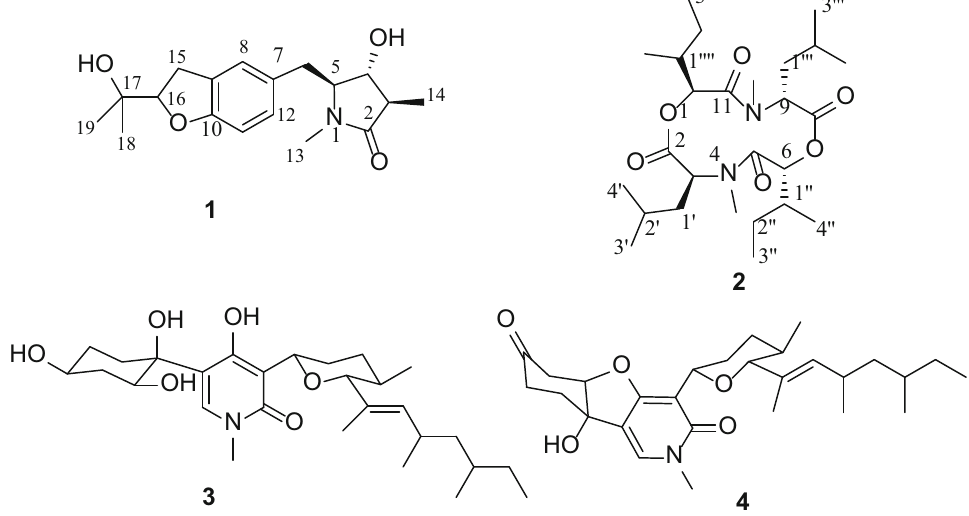
Fig. 1 Structures of compounds 1 – 4 from F. tricinctum SYPF